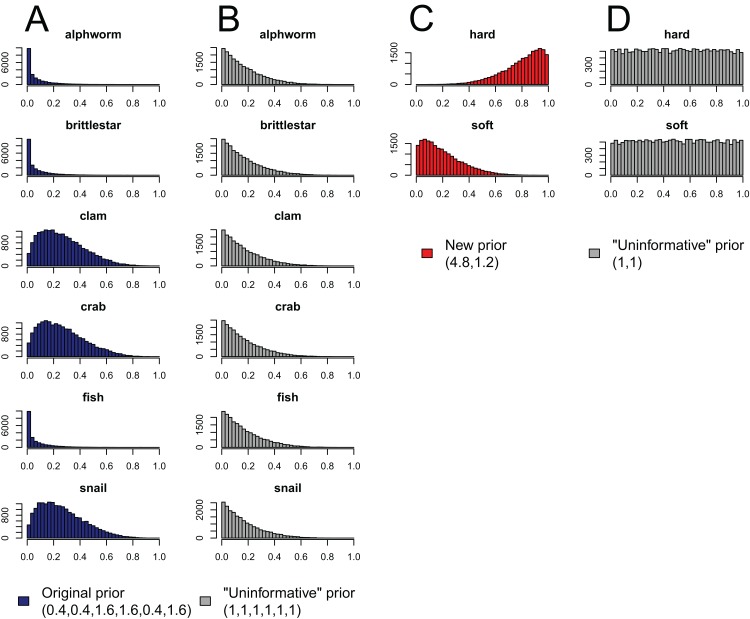
Effect of aggregating sources a posteriori on priors in mixing models, produced by the “combine_sources” function in MixSIAR as a warning to the user.(A) the original, unaggregated prior on six sources from the mantis shrimp example (dark blue); (B) the “uninformative”/generalist prior on six sources (grey); (C) the prior resulting from aggregating the six-source prior in dark blue into two sources (hard-shelled = clam + crab + snail, soft-bodied = alphworm + brittlestar + fish, red); and (D) the prior resulting from aggregating the six-source “uninformative”/generalist prior into the same two sources (grey).